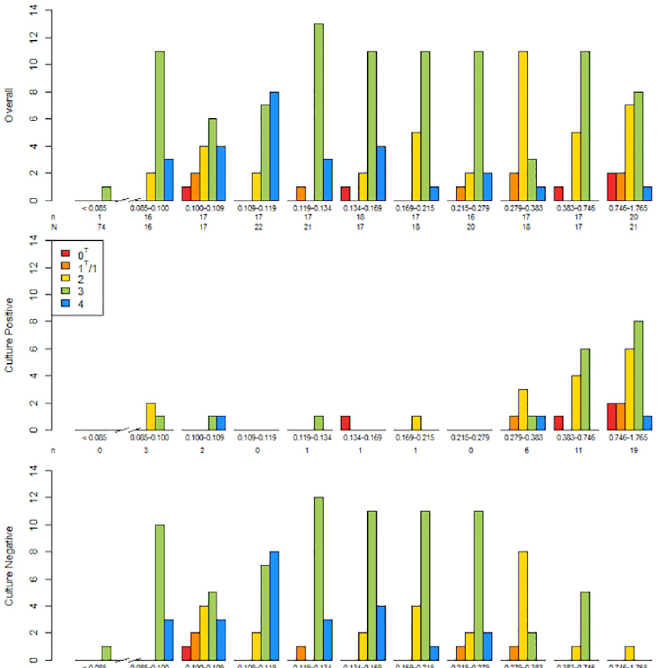
Fig 3. Distribution of 2-ponA genotypes (sequencing results) in 261 HIV-infected pulmonary TB suspects in Mbarara, Uganda according to TOP TB assay OD values. Results are shown for all subjects (top), and then separated by those that were culture-positive (middle) and culture-negative (bottom). The X- axis is divided into groups of subjects with similar bacterial loads as measured by TOP OD values. The first group (far left) includes 74 subjects that were culture-negative and TOP-negative (3-ponA primer). N denotes the number of subjects in each TOP OD group; n denotes the number of subjects with a positive 2-ponA genotype in each group. A 2-ponA genotype could not be identified in 8% (4/48) culture-positive/TOP-positive samples and 8% (11/139) culture-negative/TOP-positive samples. A 2-ponA genotype was identified in 1% (1/74) of culture-negative/TOP-negative